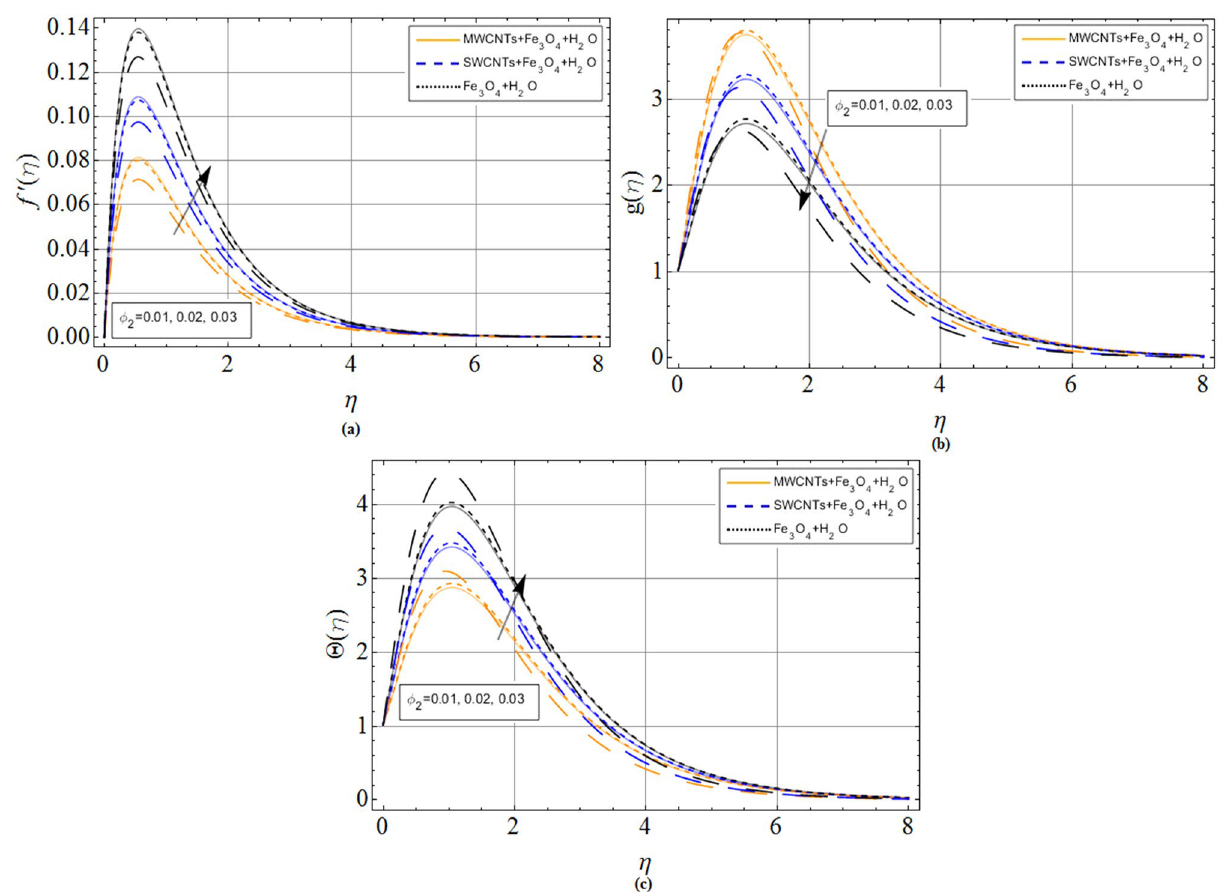
Figure 5. Volume friction parameter φ 2 ( Fe 3 O 4 ) effect on ( a ) axial velocity f ′ (η) ( b ) radial velocity g (η) ( c ) temperature �(η) . When φ 1 = 0.01, φ 2 = 0.2, Sc = 2.0, Pr = 6.2, M = 1.0, N =